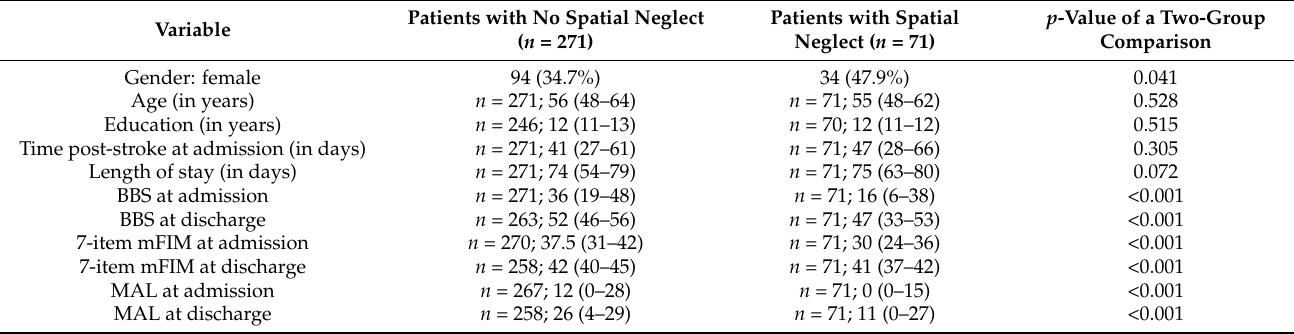
Table 1. Patient